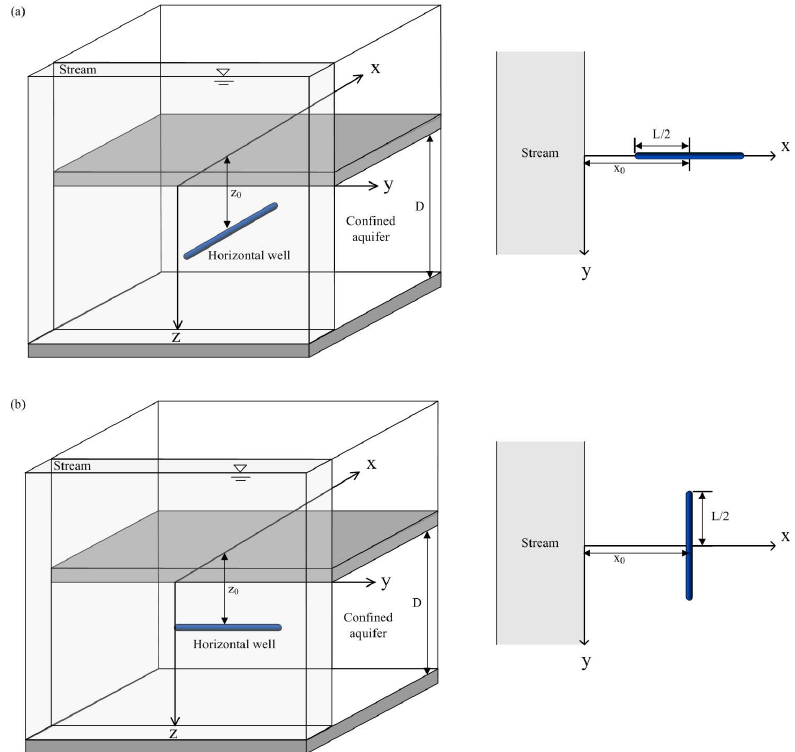
Fig. 2. Schematic diagram of horizontal well for β = 0 and α = (a) 0 (b) 90